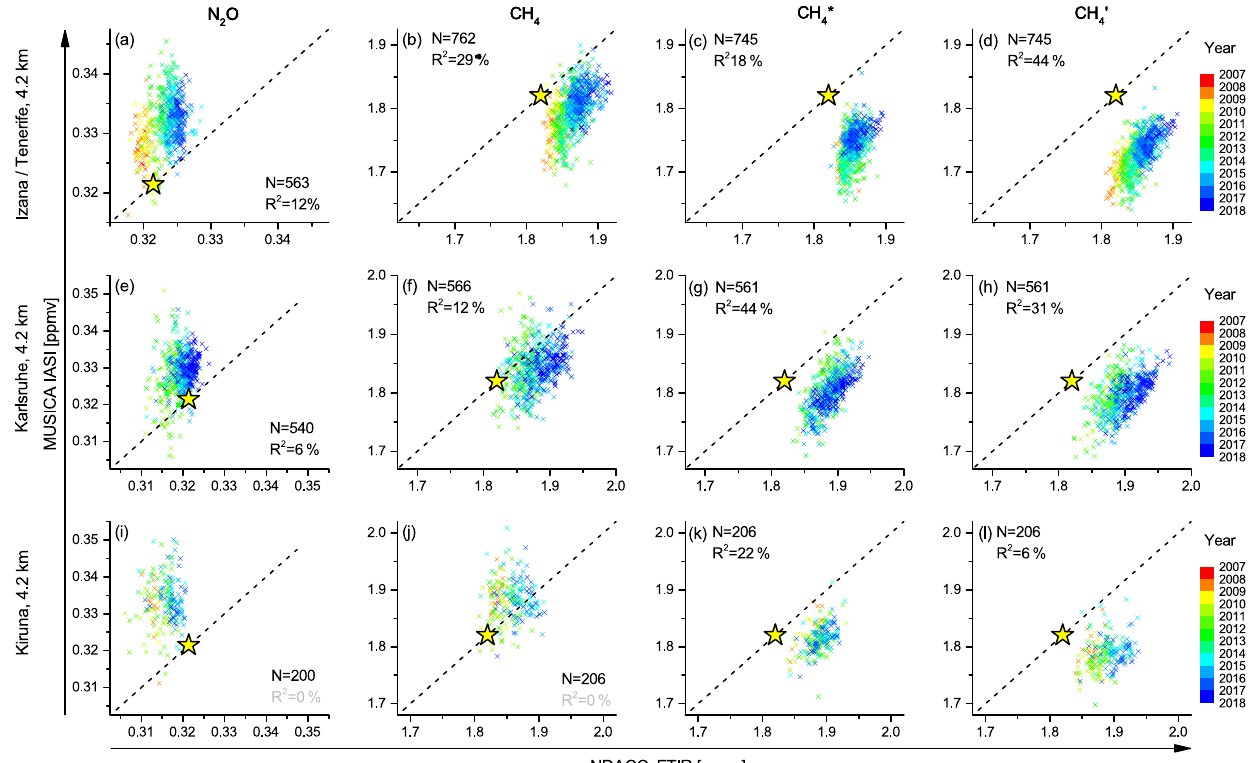
Figure 11. Same as Fig. 10, but for correlation between the daily mean MUSICA IASI products (4.2km retrievals) and NDACC FTIR products (4.2km retrievals): (a–d) for the surroundings of Tenerife Island; (e–h) for the surroundings of Karlsruhe; (i–k) for the surroundings of Kiruna; (a) , (e) and (i) for N 2 O; (b) , (f) and (j) for CH 4 ; (c) , (g) and (k) for CH ∗ significant positive correlations (95% confidence level) and grey indicate no